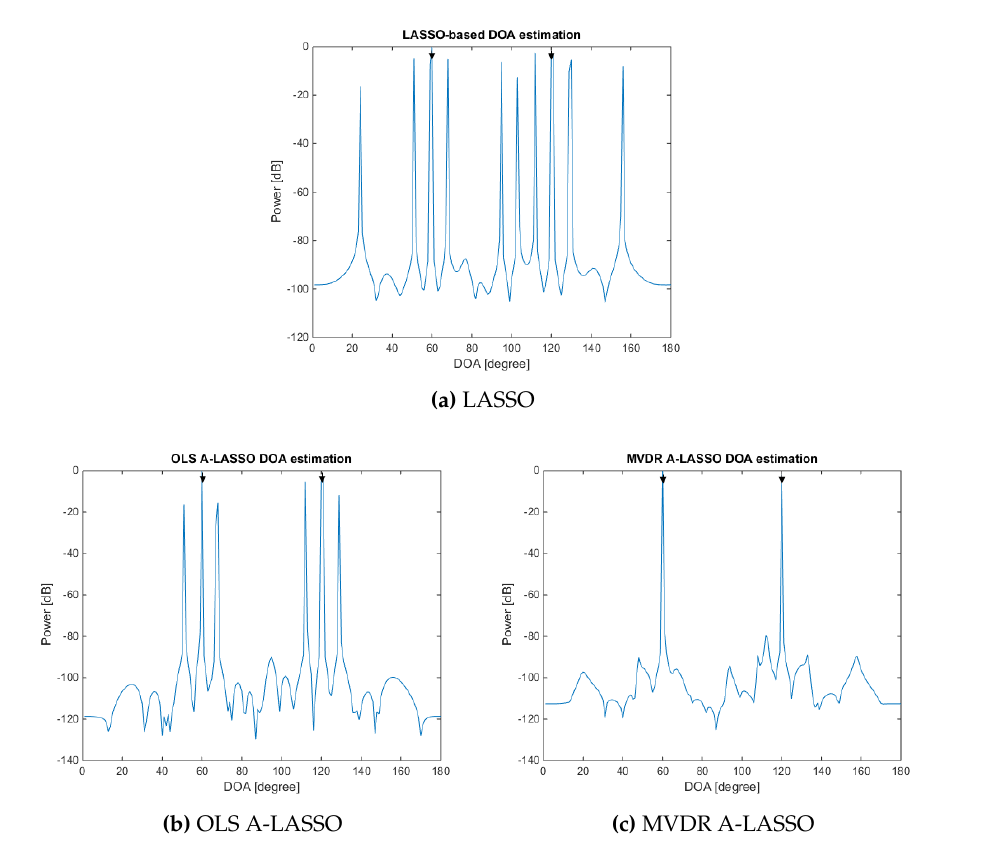
Figure 5. Performance of LASSO, OLS A-LASSO and MVDR A-LASSO, for two source signals at DOAs 60 ◦ and 120 ◦ , 10 snapshots, SNR = 0 dB and one iteration. ( a ) LASSO; ( b ) OLS A-LASSO; and ( c ) MVDR A-LASSO.